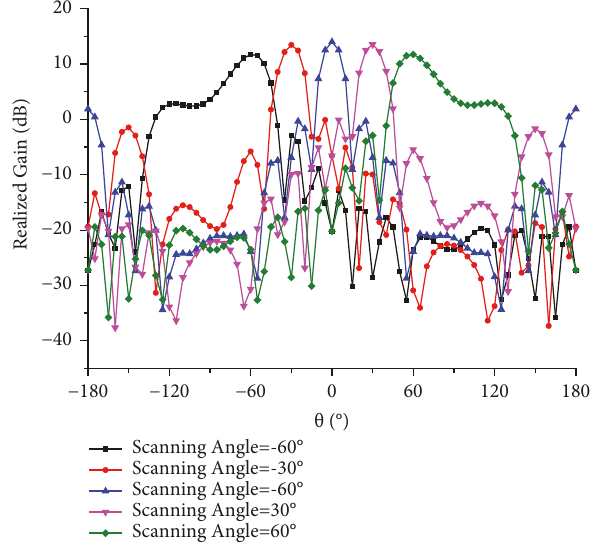
Figure 11: H-plane radiation patterns at 𝜃 = 0 ∘ , ±30 ∘ ,±60 ∘ of the DRA array at 12GHz.